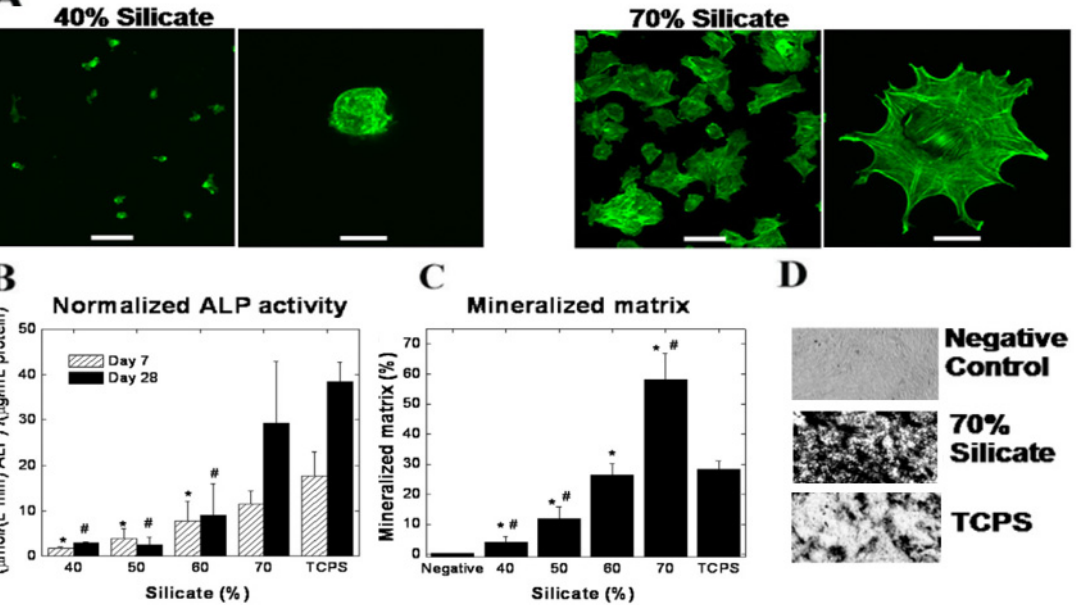
Figure 16 . ( A ) Representative confocal imagens of preosteoblast cells at the PEO nanocomposite surface. F-actin was stained to demonstrate the enhanced cell adhesion, spreading, and proliferation caused by the presence of laponite. ( B ) Quantification of ALP activity. A 6-fold increase in ALP activity was observed on day 7 and a 10-fold increase on day 28 when silicate concentration increases from 40% to 70%. ( C , D ) Qualitative and quantitative evaluation of mineralized matrix after 28 days with positive control (TCPS). (Adapted with permission from [57]. Copyright 2011, Elsevier).